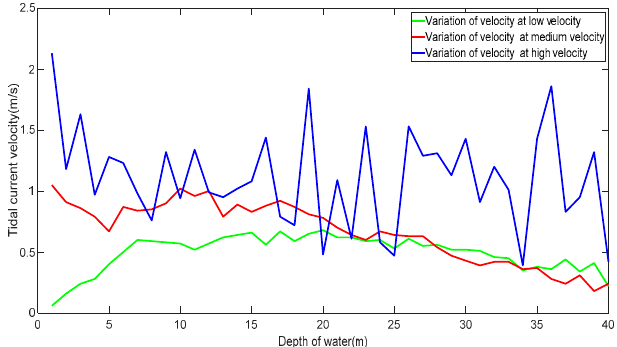
Figure 1. Distribution diagram of tidal current velocity distribution from the surface of the sea to 40 m under the sea surface. The green line presents the tidal current at low velocity condition; the red line presents the tidal current at medium velocity condition; the blue line presents the tidal current at high velocity condition. Energies 2020 , 13 , x FOR PEER REVIEW